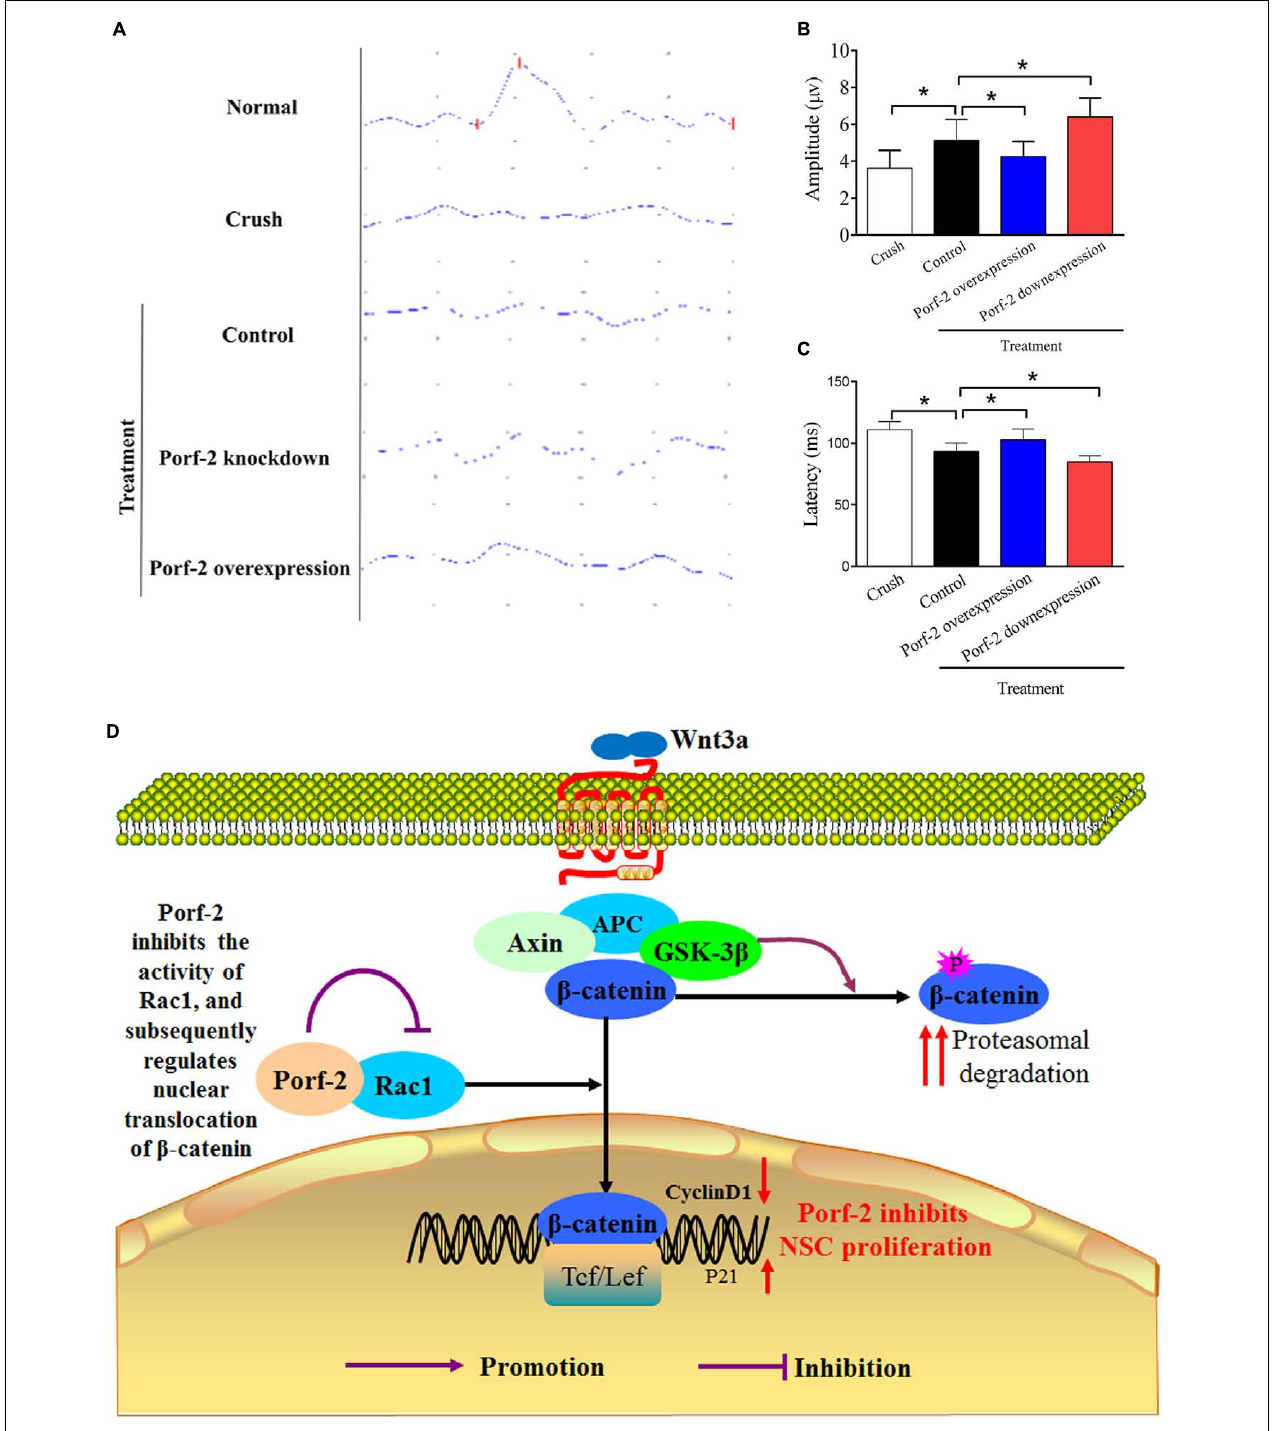
FIGURE 7 | Evaluation of the recovery of the injured optic nerve by NPN wave pattern after transplantation. (A) Representative flash visual evoked potentials (F-VEP) tracings at 10 weeks after optic nerve crush injury in Crush, Porf-2-overexpression, Porf-2 knockdown and Control (GFP-NSCs) groups. (B) Bar charts showing F-VEP latency ( n = 6 rats). (C) Bar charts showing F-VEP amplitude ( n = 6 rats), ∗ p < 0.05. (D) Exploration of the mechanism by which Porf-2 exerts its anti-proliferative effects on hippocampus-derived NSCs. Briefly, a direct interaction between Porf-2 and Rac1 reduces the activity of Rac1, which induces the nuclear translocation of β -catenin. β -catenin in the nucleus subsequently activates nuclear transcription factors and inactivates inhibitory factors, thereby resulting in the phosphorylation of many target proteins and finally regulating the proliferation of NSCs. P (red or purple): different sites of phosphorylation.